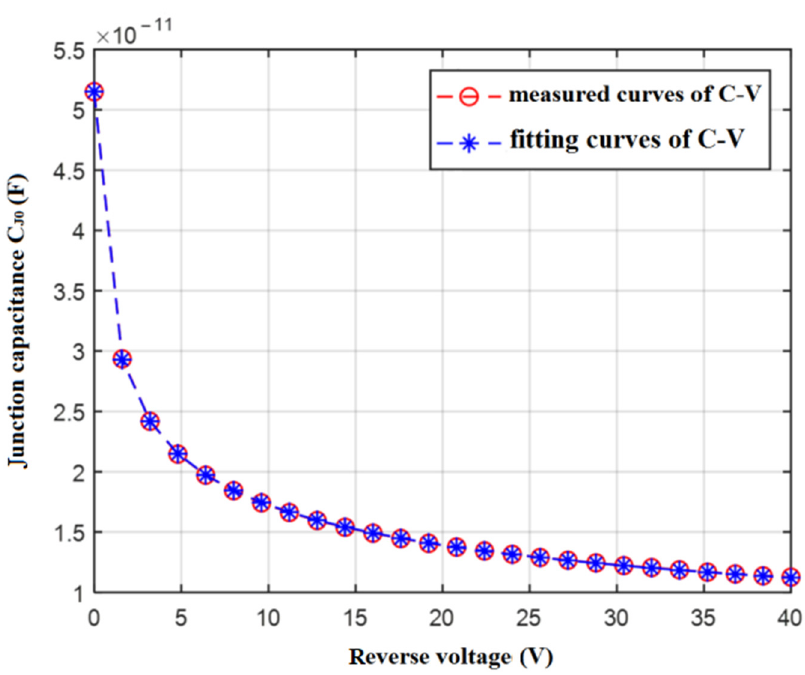
Figure 12. Comparison of fitting and measured curves of junction capacitance characteristics.